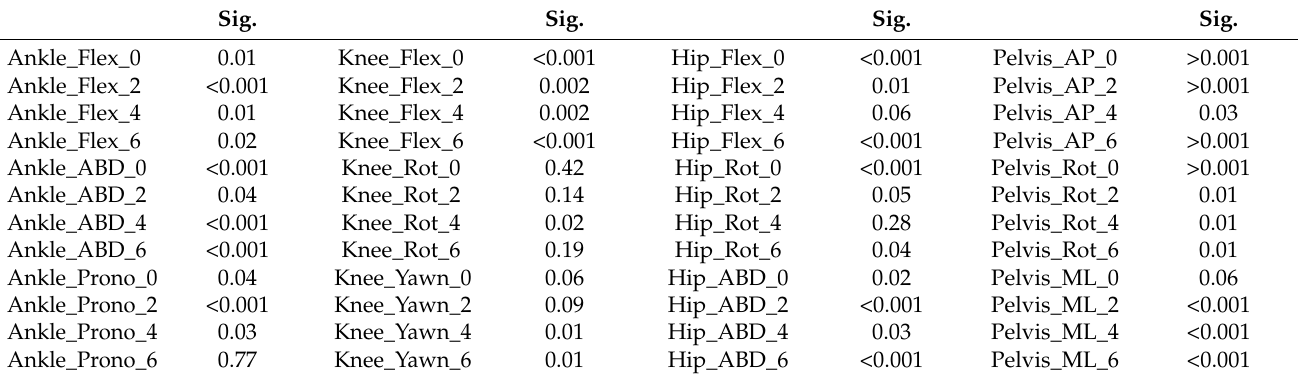
Table 2. ANOVA of the kinematic variables Ankle flex: ankle flexion; Ankle_ABD: ankle abduc- tion; Knee_flex: knee flexion; knee_rot: knee rotation; Hip_flex: hip flexion; Hip_rot: hip rotation; Hip_ABD: hip abduction; Pelvis_AP: pelvis front-back; Pelvis_Rot: pelvis rotation; Pelvis_ML: